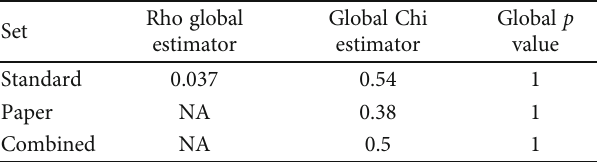
Table 4: Hospital joint Cox proportional hazards test. Table 5: Tests global signi fi cance variables Cox PH model